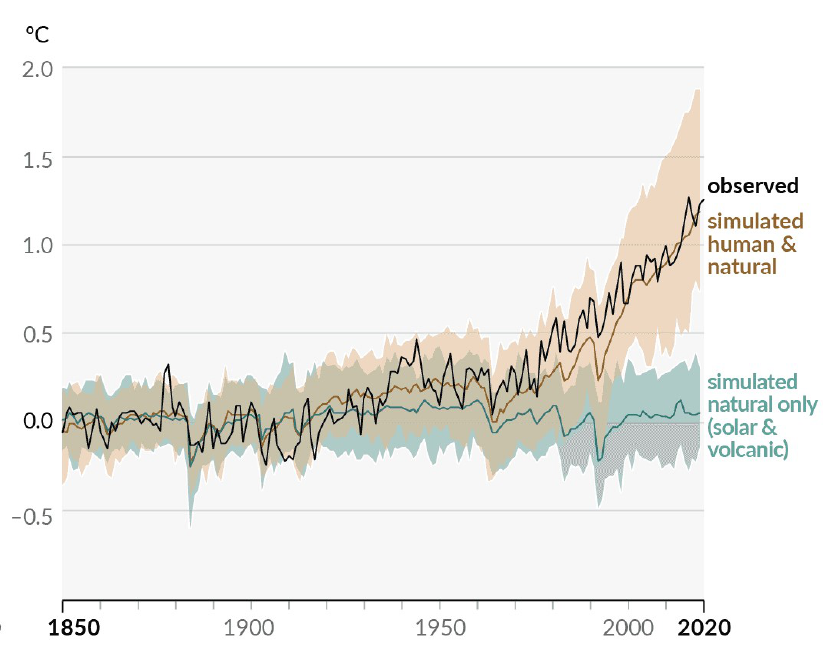
Figure 1. Observed and simulated history of global surface temperature changes (annual average) and causes of recent warming, demonstrating model skills